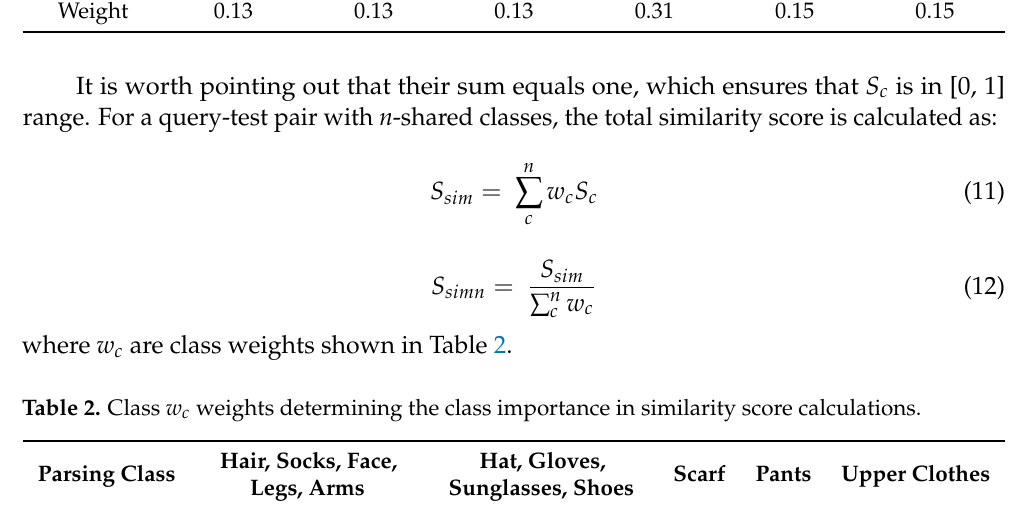
Hat, Gloves, Sunglasses, Shoes